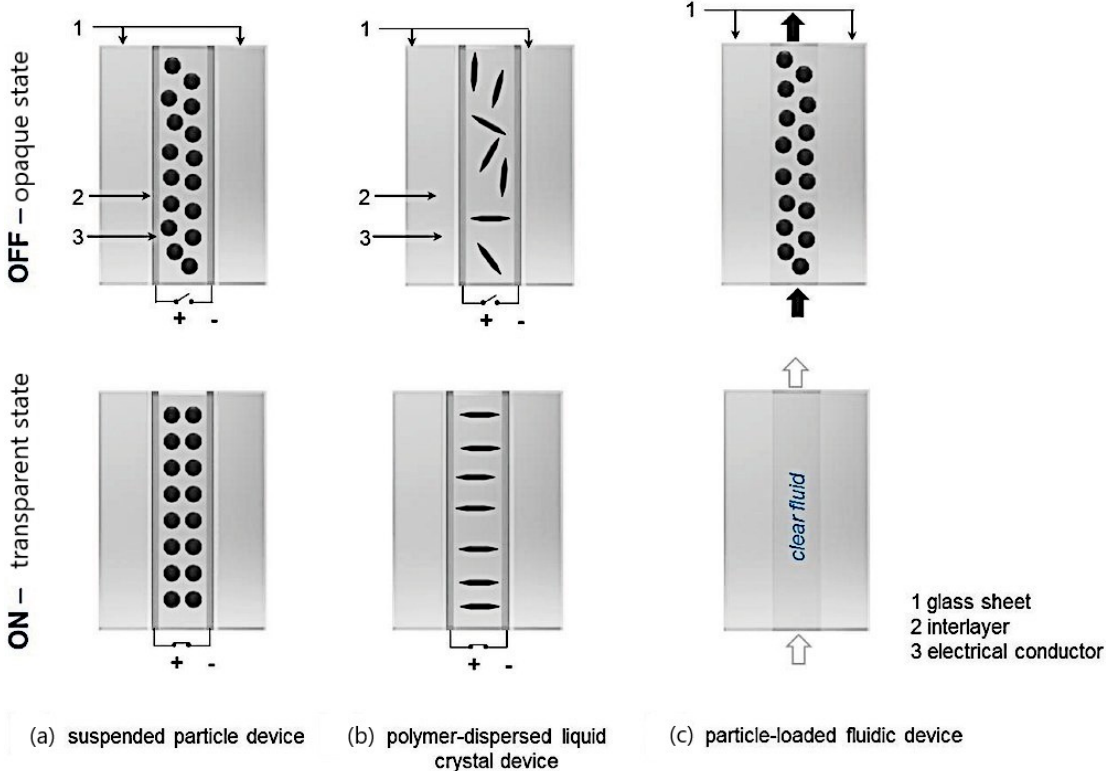
Figure 15. Suspended particle device (SPD) technologies for switchable shading and control of optical transparency. An active fluid is contained within a glass–glass laminate in which an external trigger allows for variable orientation of ( a ) suspended particles or ( b ) liquid crystals. ( c ) A passive fluid with variable transparency flows through a microfluidic device (adapted from [111] with permission from John Wiley and Sons).